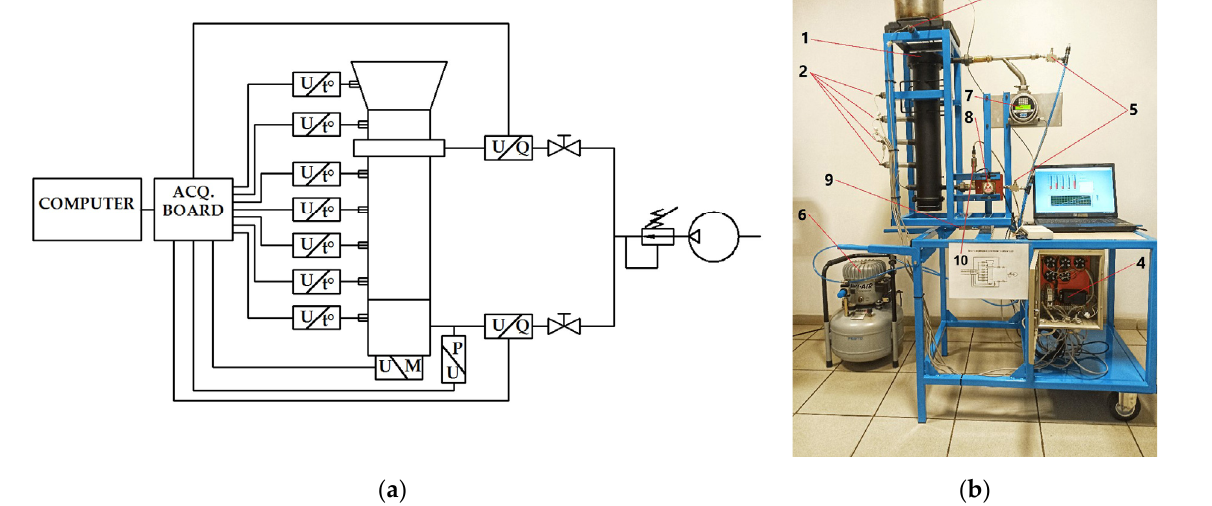
Figure 5. Test device in our laboratory: ( a ) functional diagram; ( b ) physical embodiment (1—gasifier; 2—pyrolytic front temperature probes; 3—water and flame temperature probes; 4—electric panel; 5—pneumatic throttles; 6—compressor; 7—combustion air flowmeter; 8—pyrolysis air flowmeter; 9—electronic scale; 10—pressure transducer) [25].